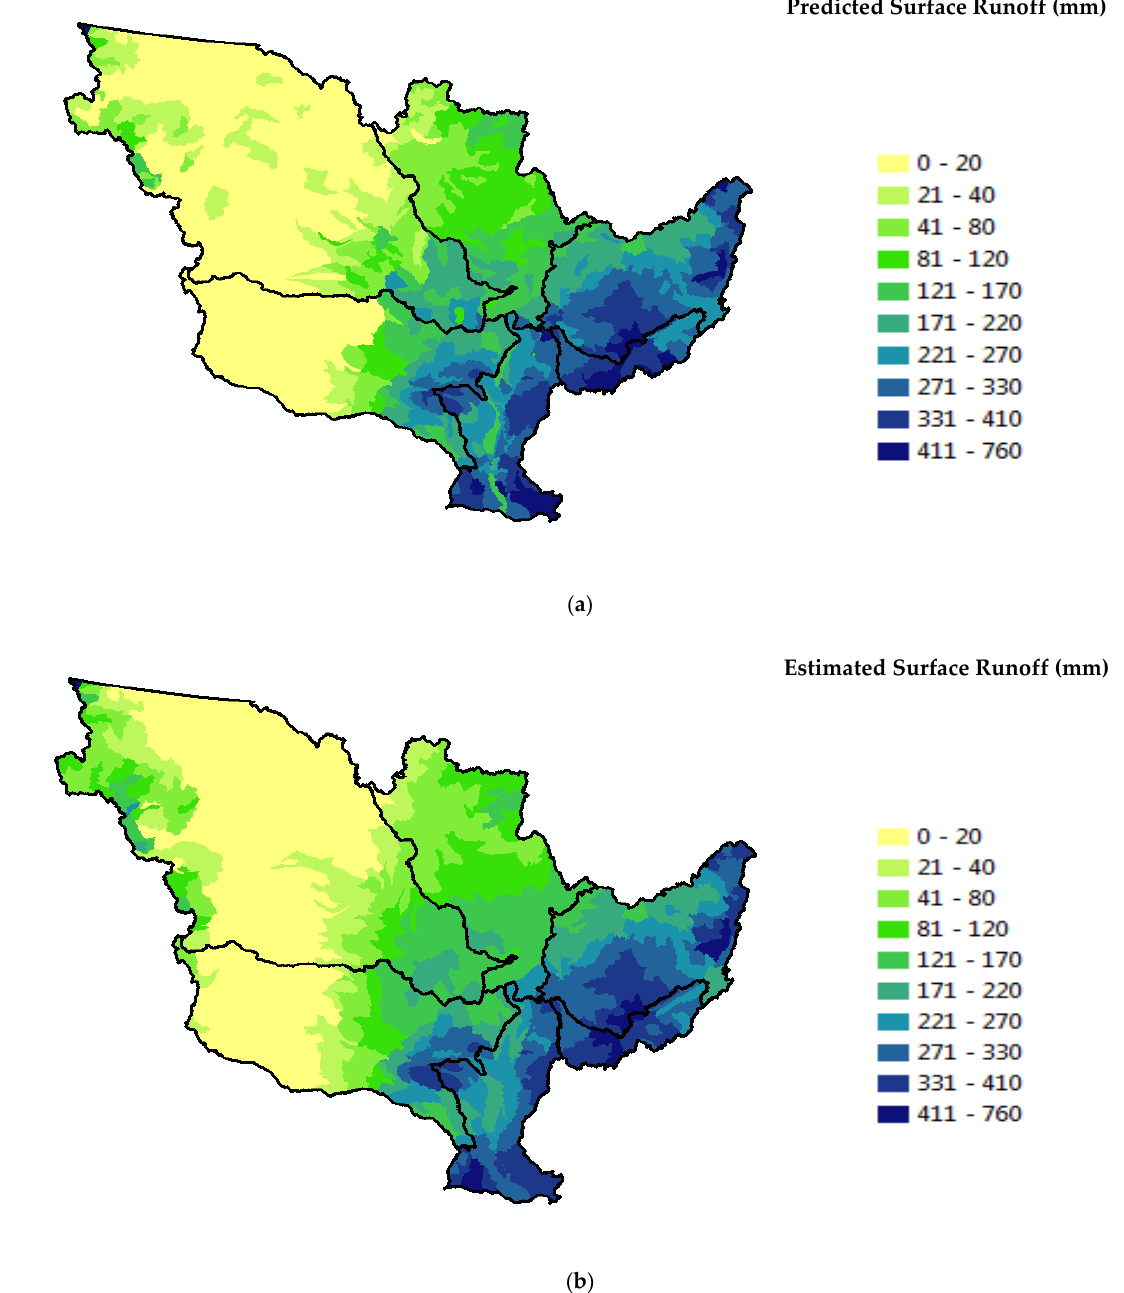
Figure 3. Comparison of surface runoff: ( a ) Model predictions; ( b ) Calibration target.